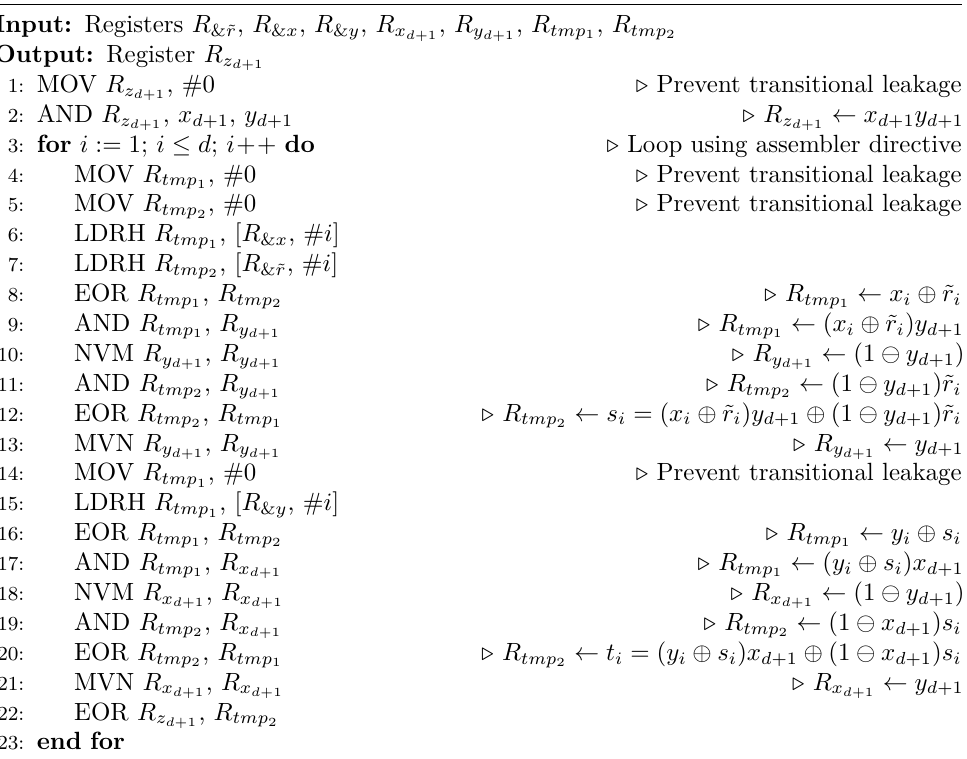
Algorithm 1 Online-computation of Mul d +1 in ARM Cortex M